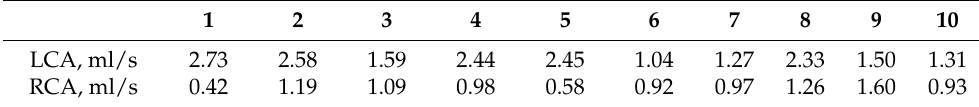
Table A1. Calculated average blood flow through LCA and RCA under nonhyperemic conditions for full trees. Resistances are distributed according to recursive algorithm.